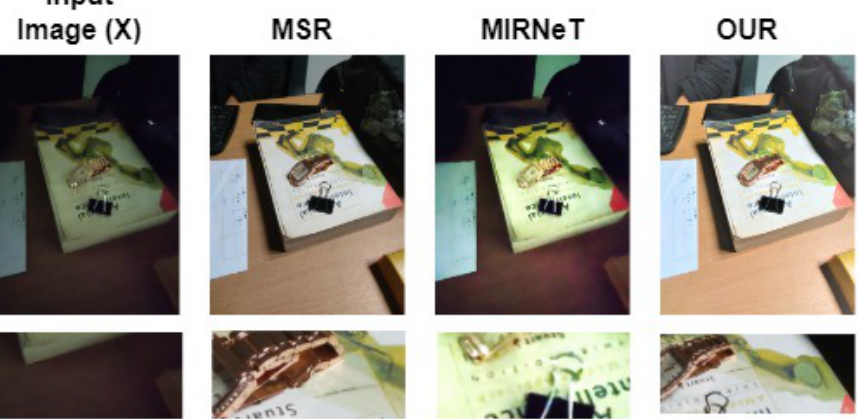
Figure 1. Some limitations of published methods for image enhancement, Input image, MSR [4], MIRNeT [5], MSR-MIRNeT (Our